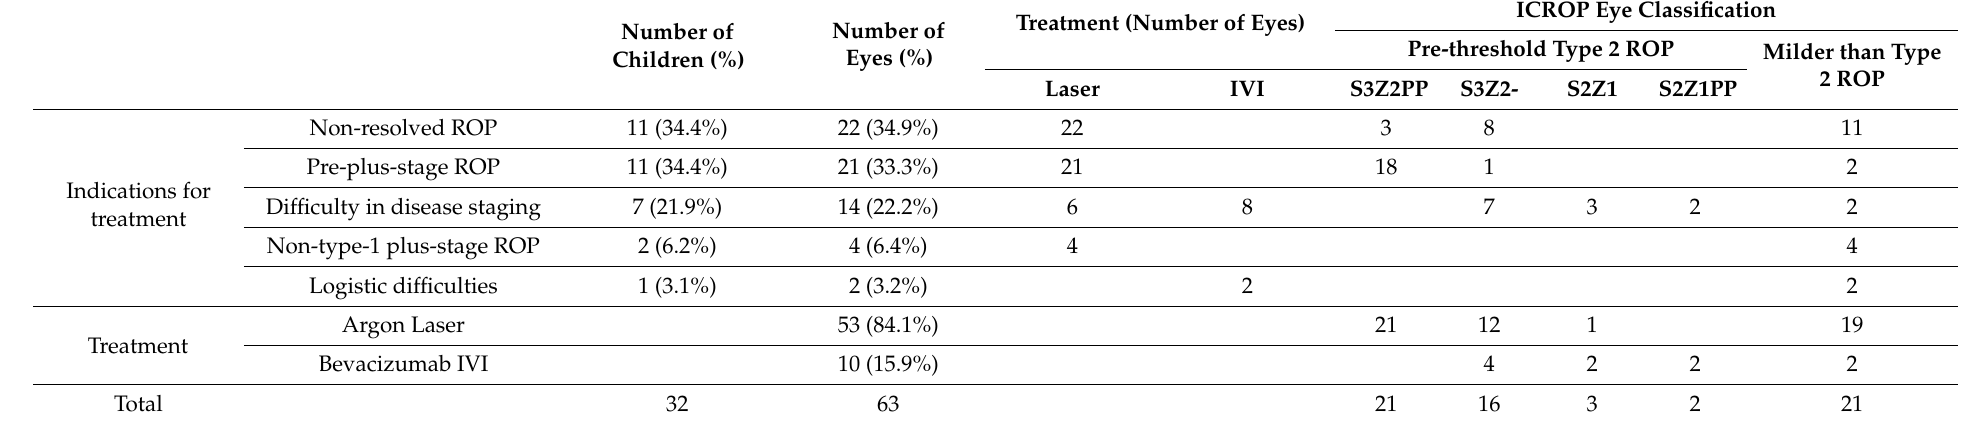
Table 2. Characteristics of off-label-treated eyes (group